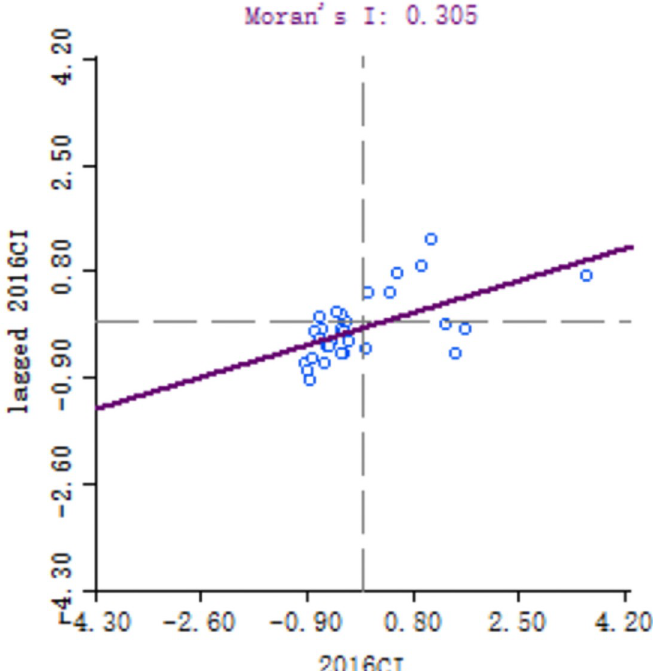
Fig 7. Moran scatter chart of industrial high quality development level in 2016.